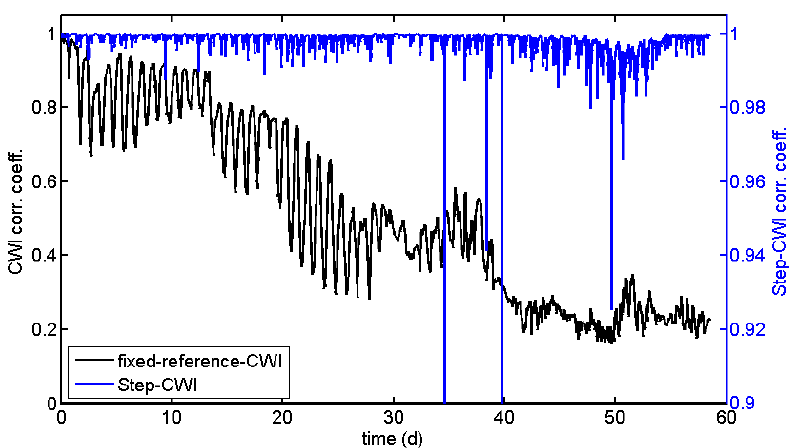
Figure 8. CWI cross-correlation coefficients for the same experiment as in Figure 6.